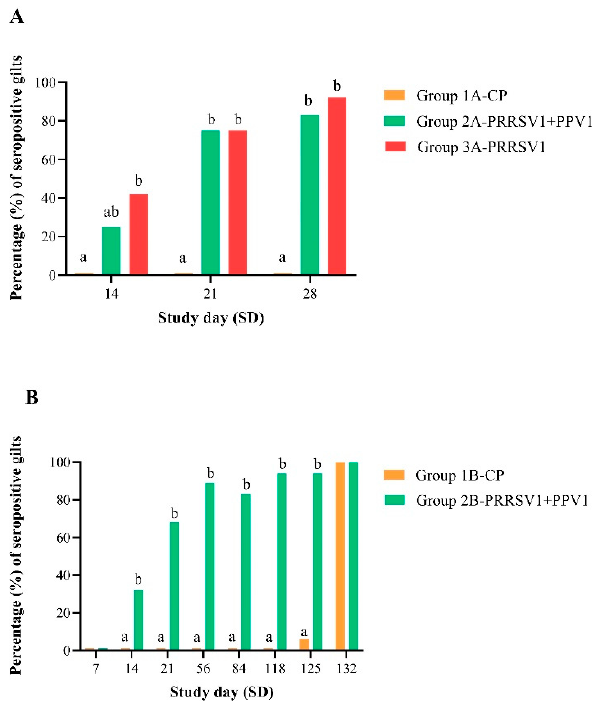
Figure 3. Proportion (%) of seropositive gilts to PRRSV at di ff erent time points in experiments A ( A ) and B ( B ). Sera were tested for PRRSV antibodies by means of a commercially available indirect ELISA kit. Frequency tables of positive results were generated and di ff erences between groups were tested by Fisher’s exact test. Di ff erent letters indicate statistical significance of di ff erences between groups.